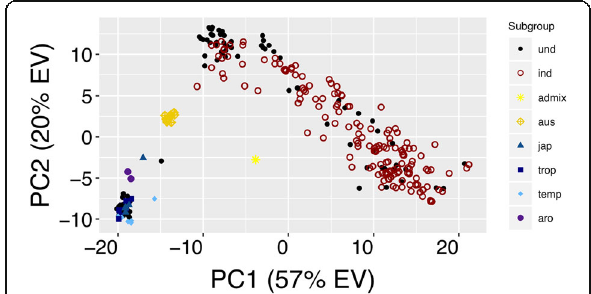
Fig. 2 Principal component analysis of 283 O. sativa accessions using the 1k-RiCA genotypic data. Principal component analysis of 283 rice accessions genotyped with 895 SNP markers using the 1k-RiCA. Subpopulation classification for 185 accessions as indica ( ind ), aus ( aus ), tropical japonica ( trop ), temperate japonica ( temp ), aromatic ( aro ), and japonica ( jap ) was defined based of Wang et al. (2018) and McCouch et